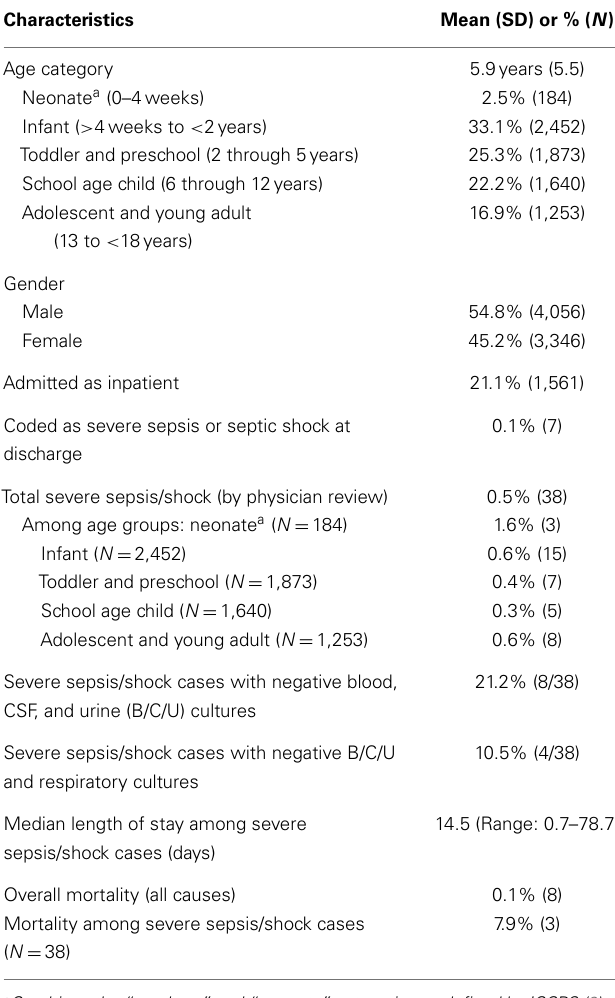
Table 3 | Characteristics of screening tool refinement group ( N = 7,402)